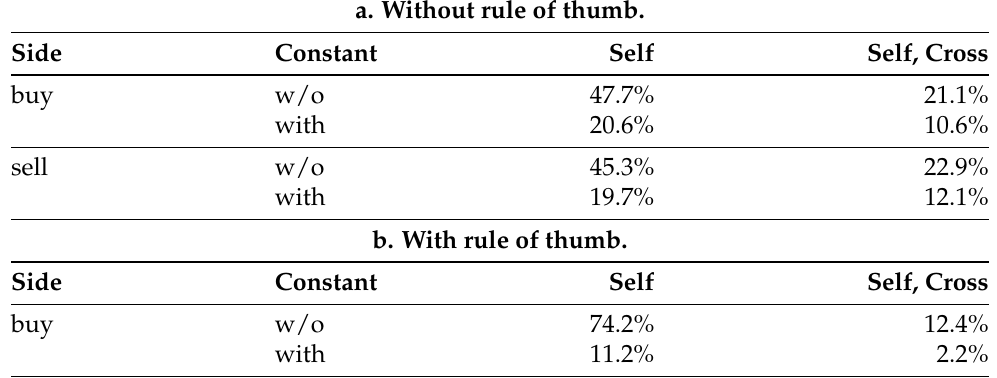
Table 3. Relative frequencies that the different models are selected on the basis of AIC differences. a. Without rule of thumb.